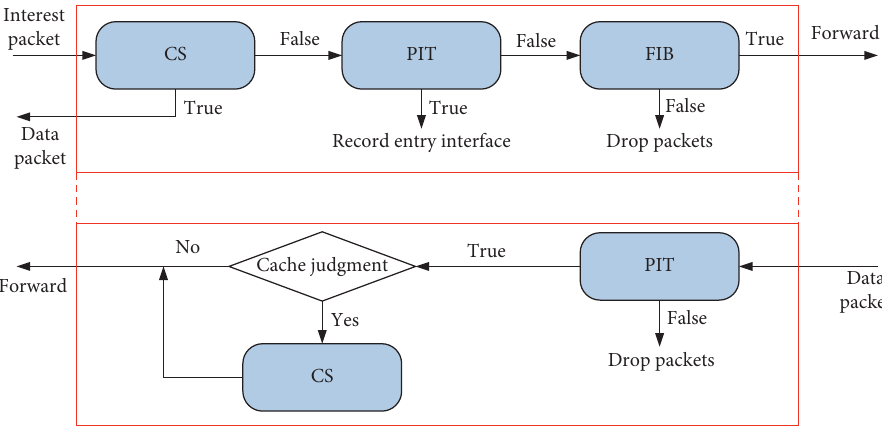
Figure 8: Schematic diagram of node forwarding request resources in the central network